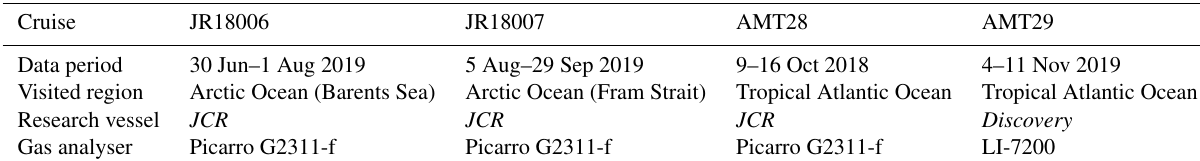
Table 1. Basic information for all four cruises on the RRS James Clark Ross ( JCR ) and RRS Discovery that measured air–sea EC CO 2 fluxes.